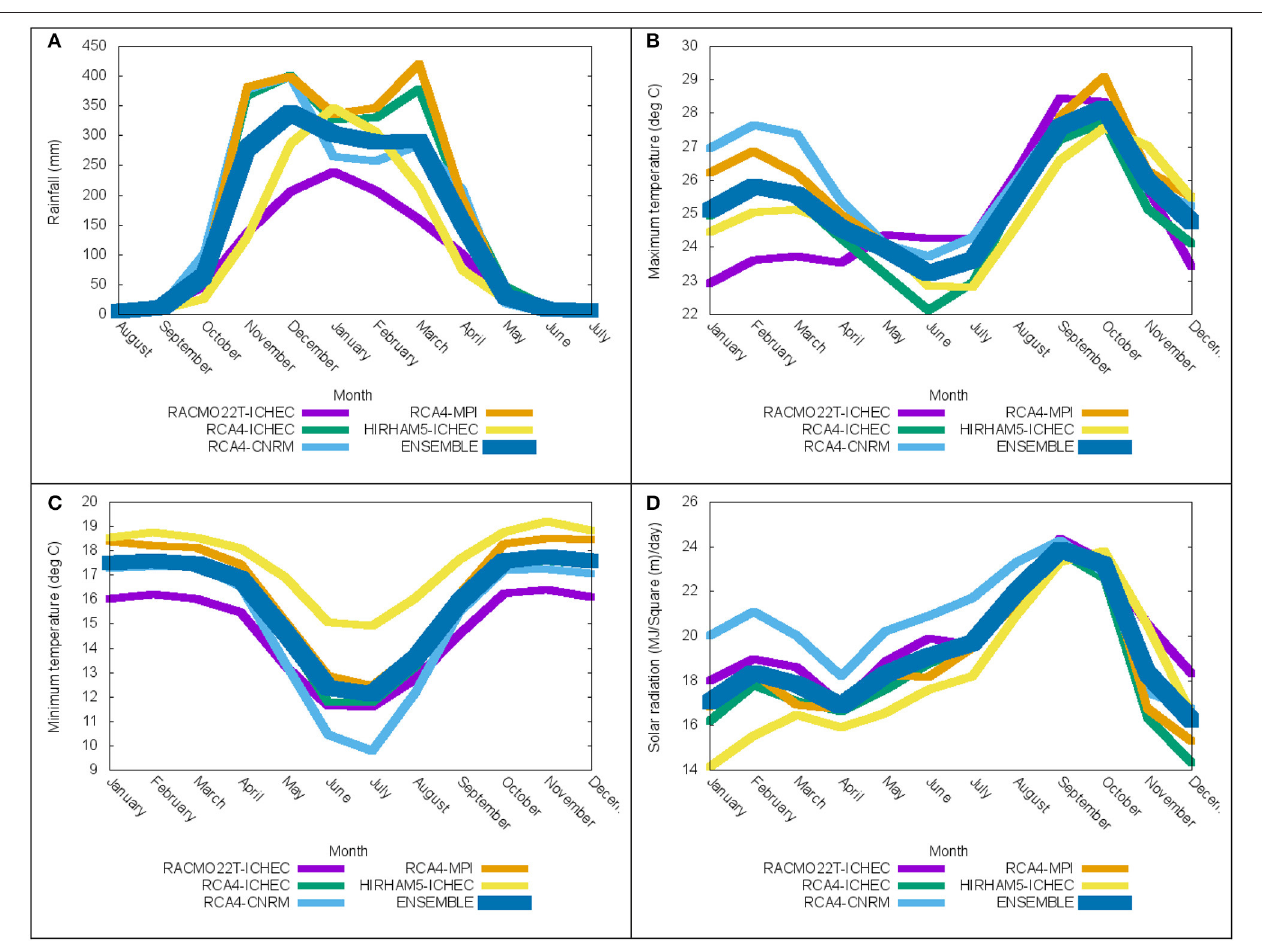
FIGURE 6 | Long-term (2010–2039) annual cycle of climate variables over southern and western highlands sub-agro ecological zones of Tanzania under RCP4.5 (A) rainfall, (B) maximum temperature, (C) minimum temperature, and (D) Solar radiation.